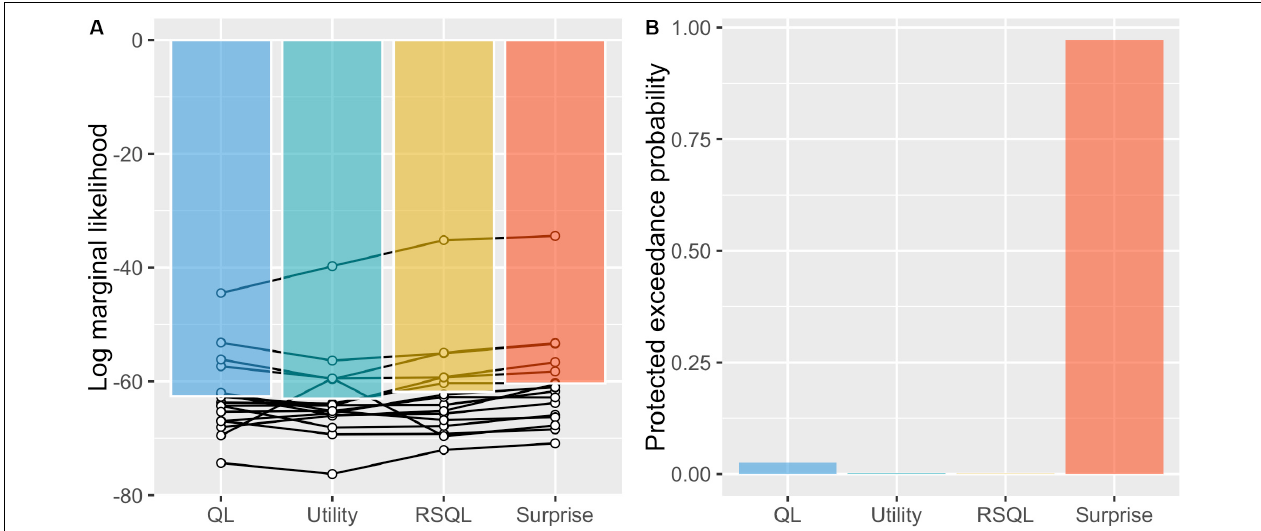
FIGURE 3 | Model selections. (A) We compared the model evidence of each model (log marginal likelihood) and found that the surprise-sensitive utility model had the largest value. (B) We carried out a Bayesian model comparison and found that the surprise-sensitive utility model had a decisively higher protected exceedance probability. QL, Q-learning model; utility, utility model; RSQL, risk-sensitive Q-learning model; surprise, surprise-sensitive utility model.